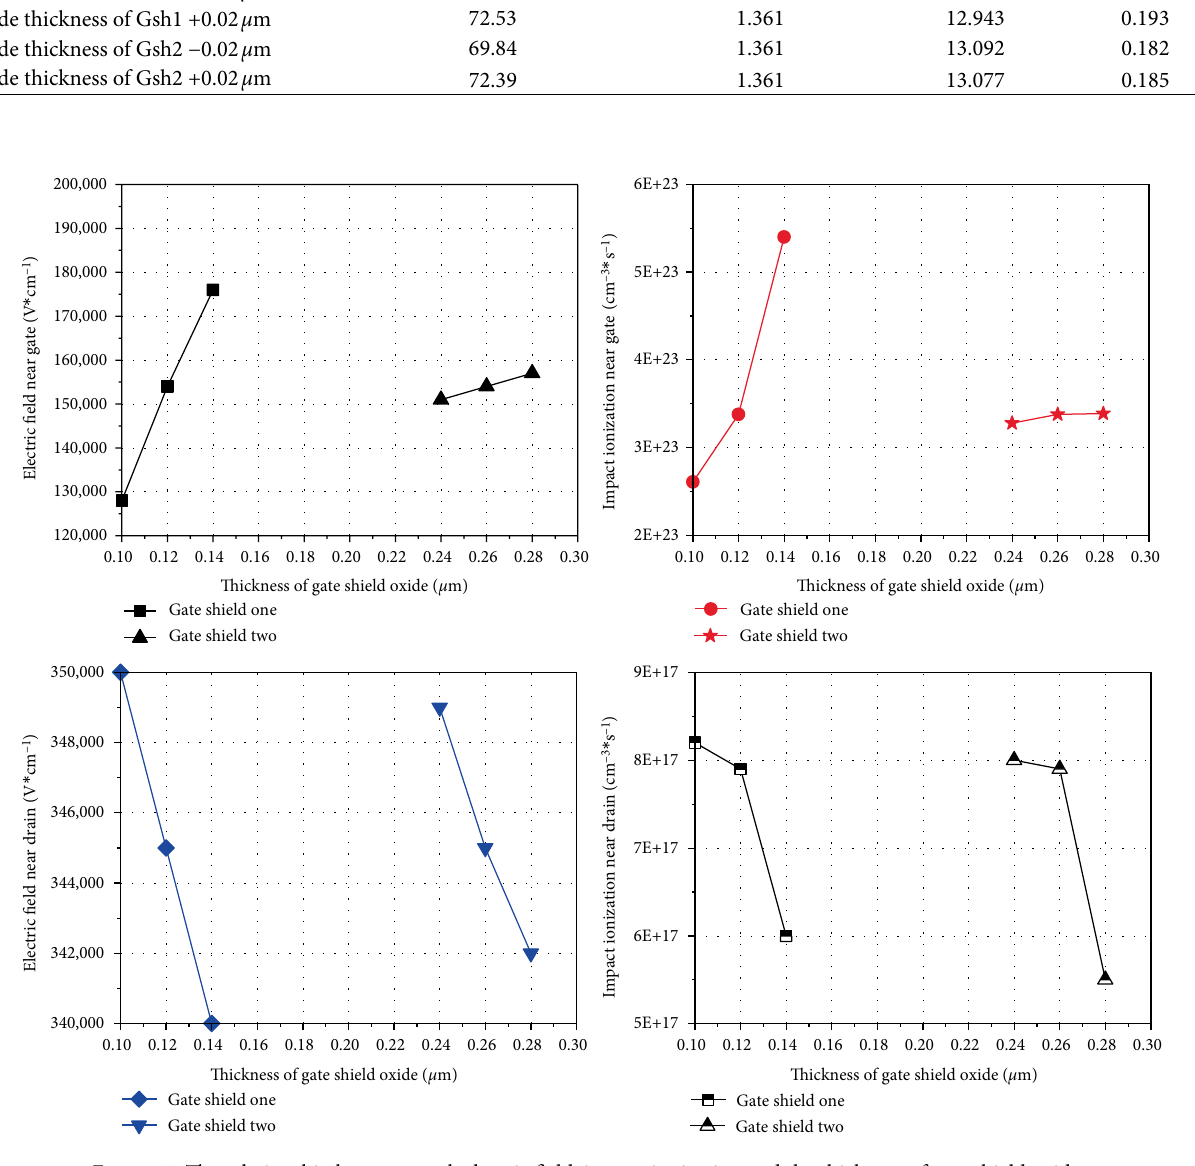
Figure 7: The relationship between peak electric field, impact ionization and the thickness of gate shield